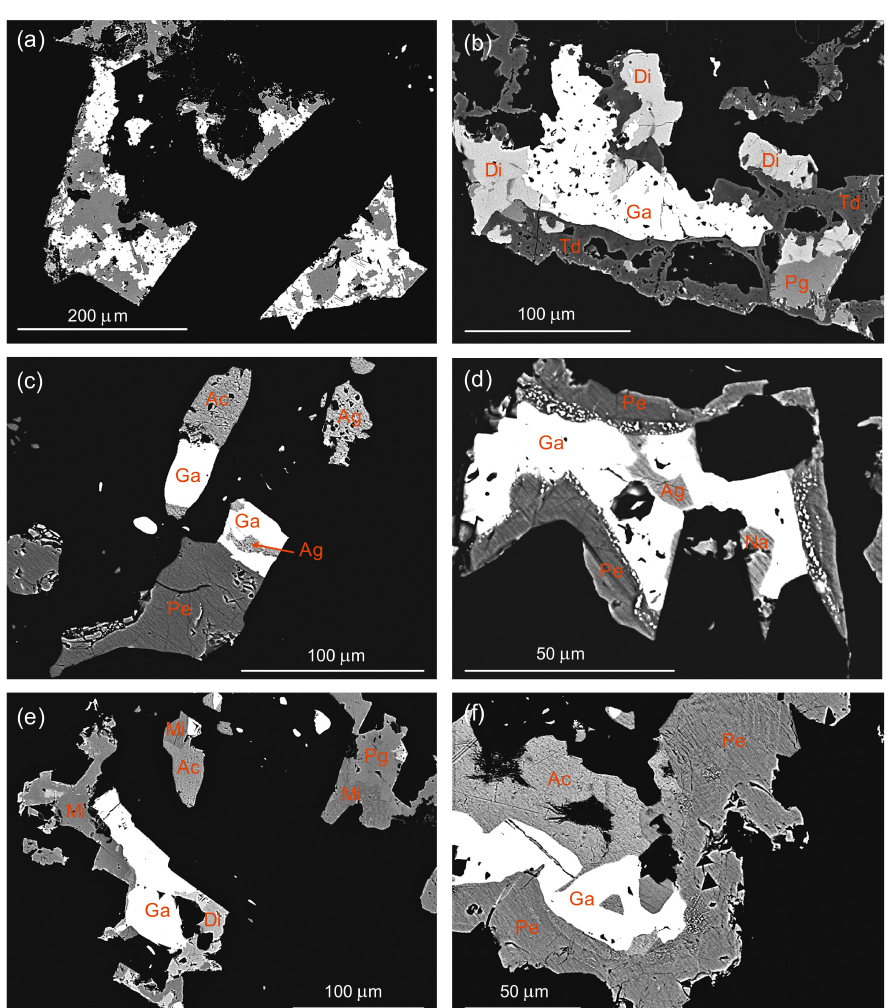
Figure 2. ( a ) Clausthalite (white) intergrown with Se-rich diaphorite (grey); ( b ) Se-rich galena (Ga) associated with diaphorite (Di), pyrargyrite (Pg) and Ag-rich tetrahedrite (Td); ( c ) aguilarite (Ag) associated with Se-rich acanthite (Ac), galena (Ga) and Se-rich pearceite (Pe); ( d ) naumannite (Na) associated with aguilarite (Ag), galena (Ga), and pearceite (Pe); ( e ) acanthite (Ac) associated with galena (Ga), pyrargyrite (Pg), miargyrite (Mi), and diaphorite (Di); ( f ) Se-rich acanthite (Ac) associated with pearceite (Pe), and galena (Ga); all back-scattered electron (BSE)